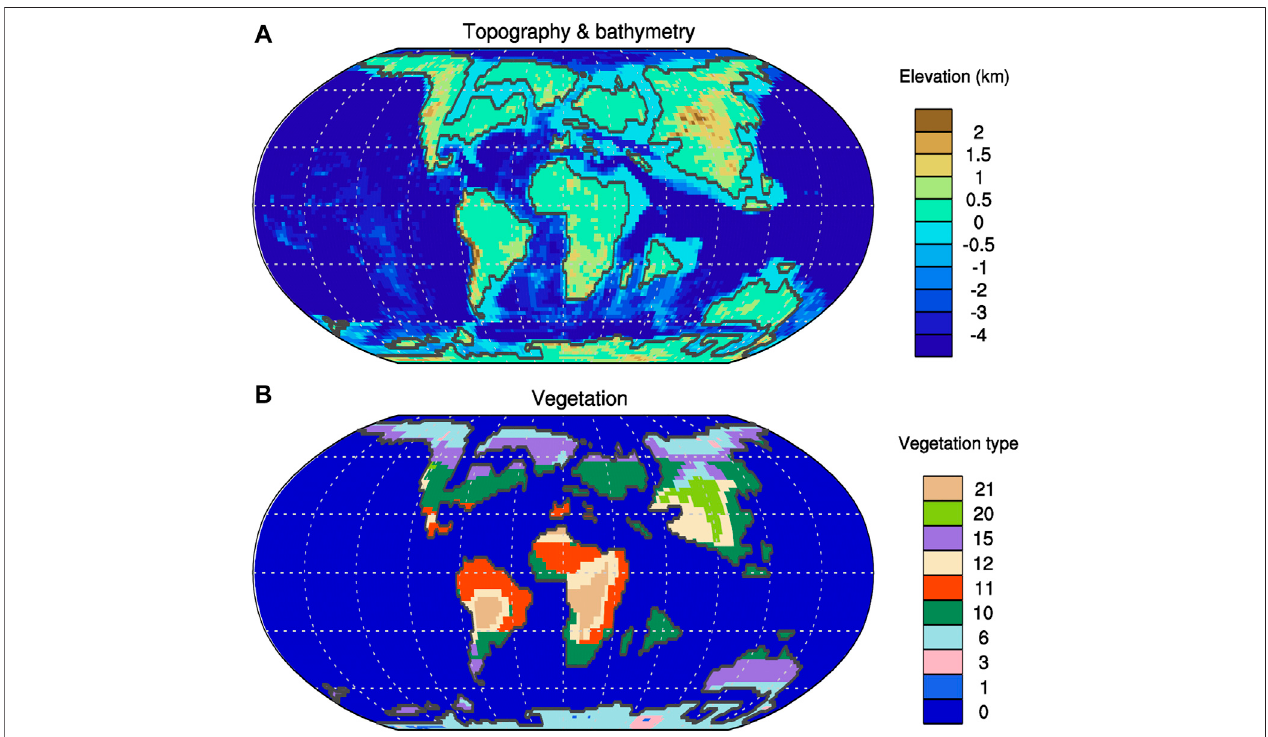
FIGURE 1 | Paleogeography (A) of 75 Ma modi fi ed from Scotese and Wright (2018) and the corresponding paleovegetation (B) interpolated from Sewall et al. (2007).In (B) ,thenumbers0isfortheocean,1forthelandice,3forthehighaltitude/latitudeevergreenconiferclosedcanopyforest,6forthehighaltitude/latitudemixed forestwithequalpercentagebroadvsneedleleafandevergreenvsdeciduous,10fortheclosedcanopy,broadleaved,moistevergreenforest,11fortheclosedcanopy, broadleaved,drydeciduousforest,12forthesavanna(dry,lowunderstorywithsparsebroadleavedoverstory),15forthehighaltitude/latitudemoist,opencanopy evergreen forest with shrub understory, 20 for the wet or cool shrubland (evergreen), and 21 for the dry or warm shrubland (deciduous), which is the same as the Land Surface Model (LSM) vegetation types.